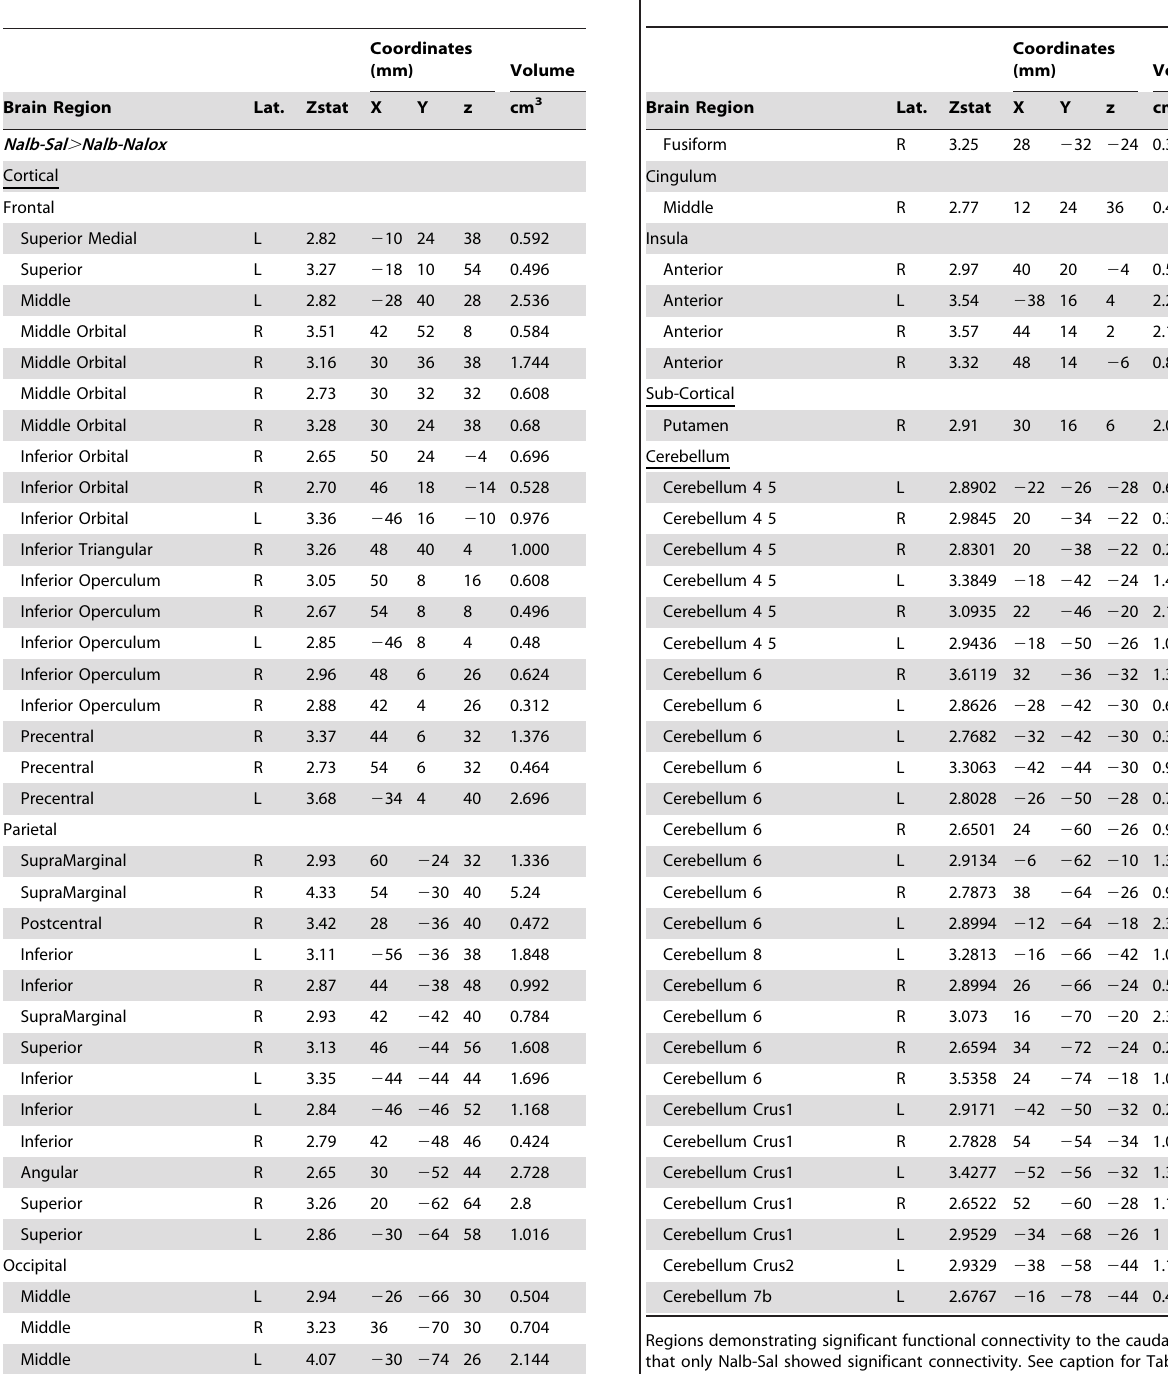
Table 4. Connectivity analysis for the